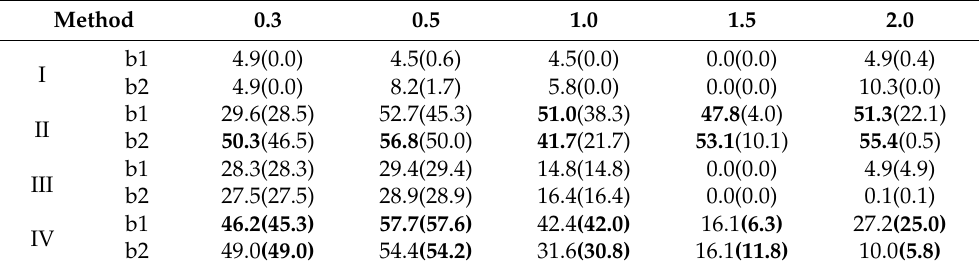
Table 3. SFSE ambiguity fixing rate and correct fixed rate of various designed and actual baseline lengths (GPS-only observations, degraded).